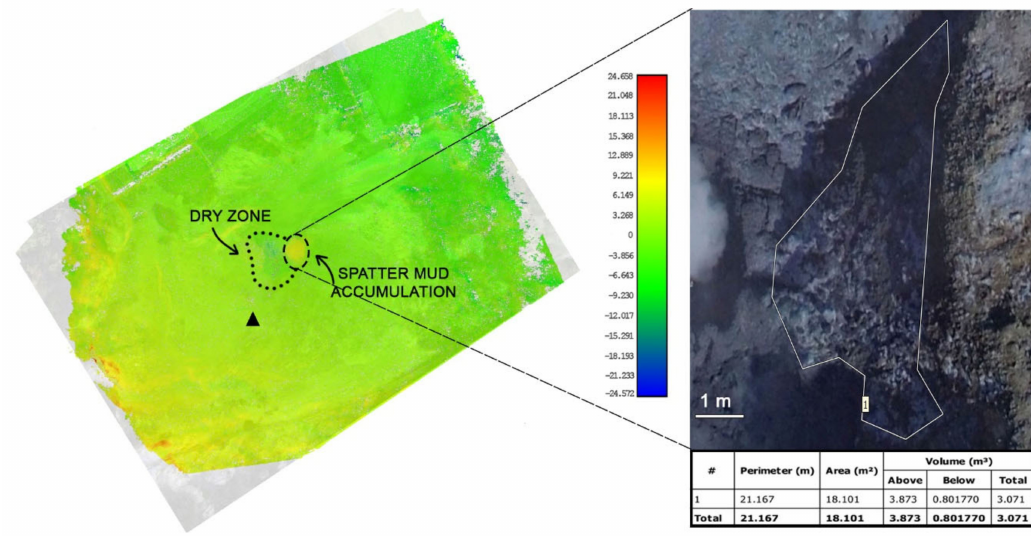
Figure 13. June–September 2020. The bubbling mud pool appears dry and a spatter mud accumulation is present near the bubbling mud pool. The right photo is a zoomed-in image of the eastern side of the